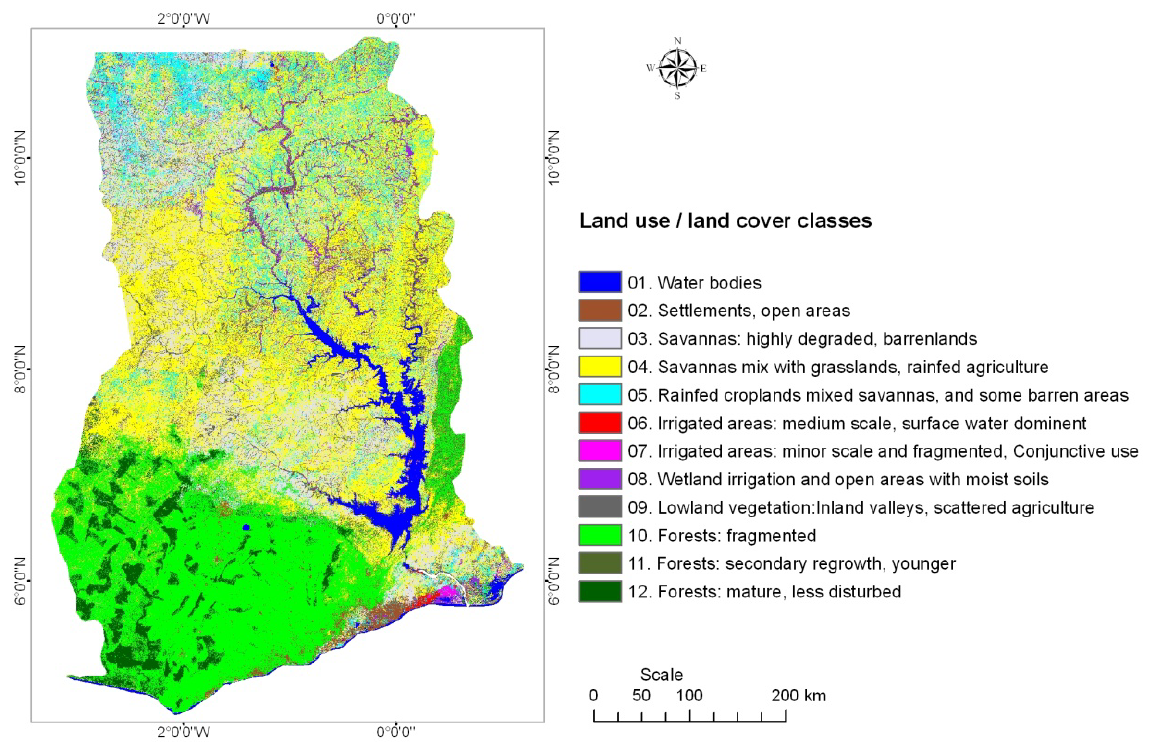
Figure 4. The final 12 LULC classes, including irrigated classes in Ghana,